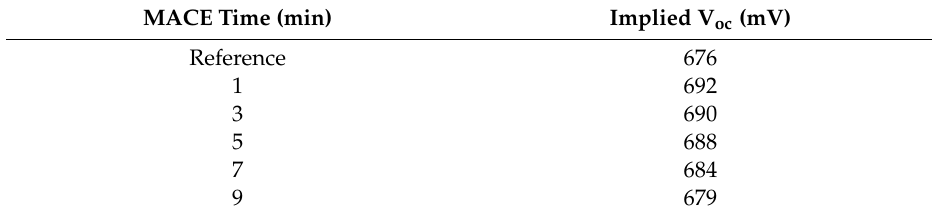
Table 1. One-sun implied V oc of the SiN x / Al 2 O 3 -passivated silicon wafers with di ff erent MACE time. The labeled “Reference” corresponds to the SiN x single layer-passivated pyramidal